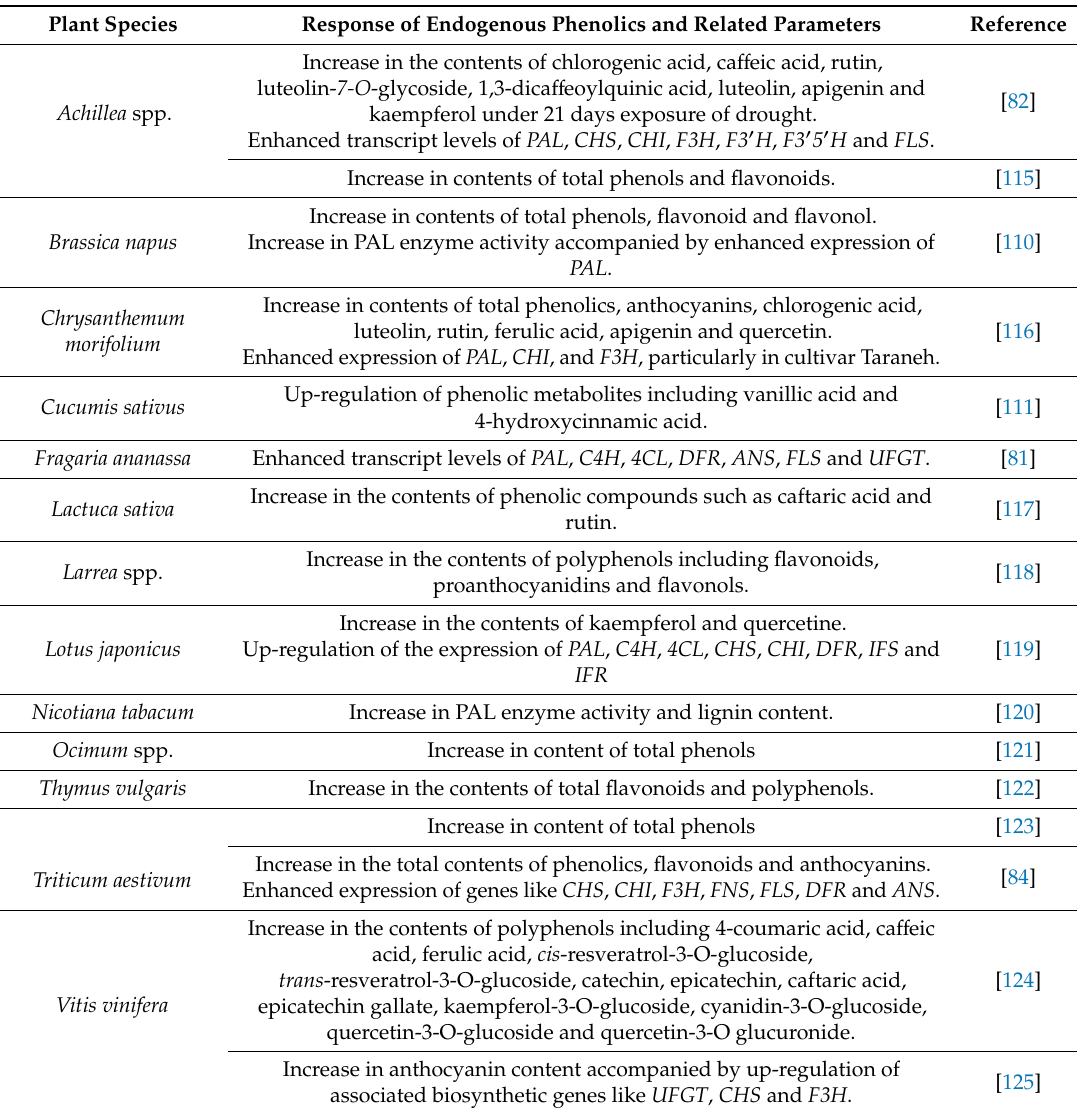
Table 2. Summary table describing the impact of drought stress on the endogenous levels of various phenolic compounds in